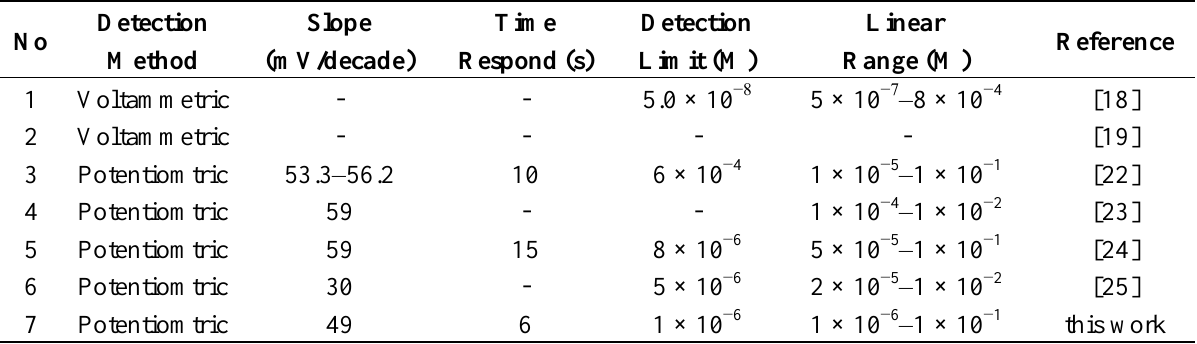
Table 2. Comparison of the result of the proposed DA sensor based on ZNRs with previous published